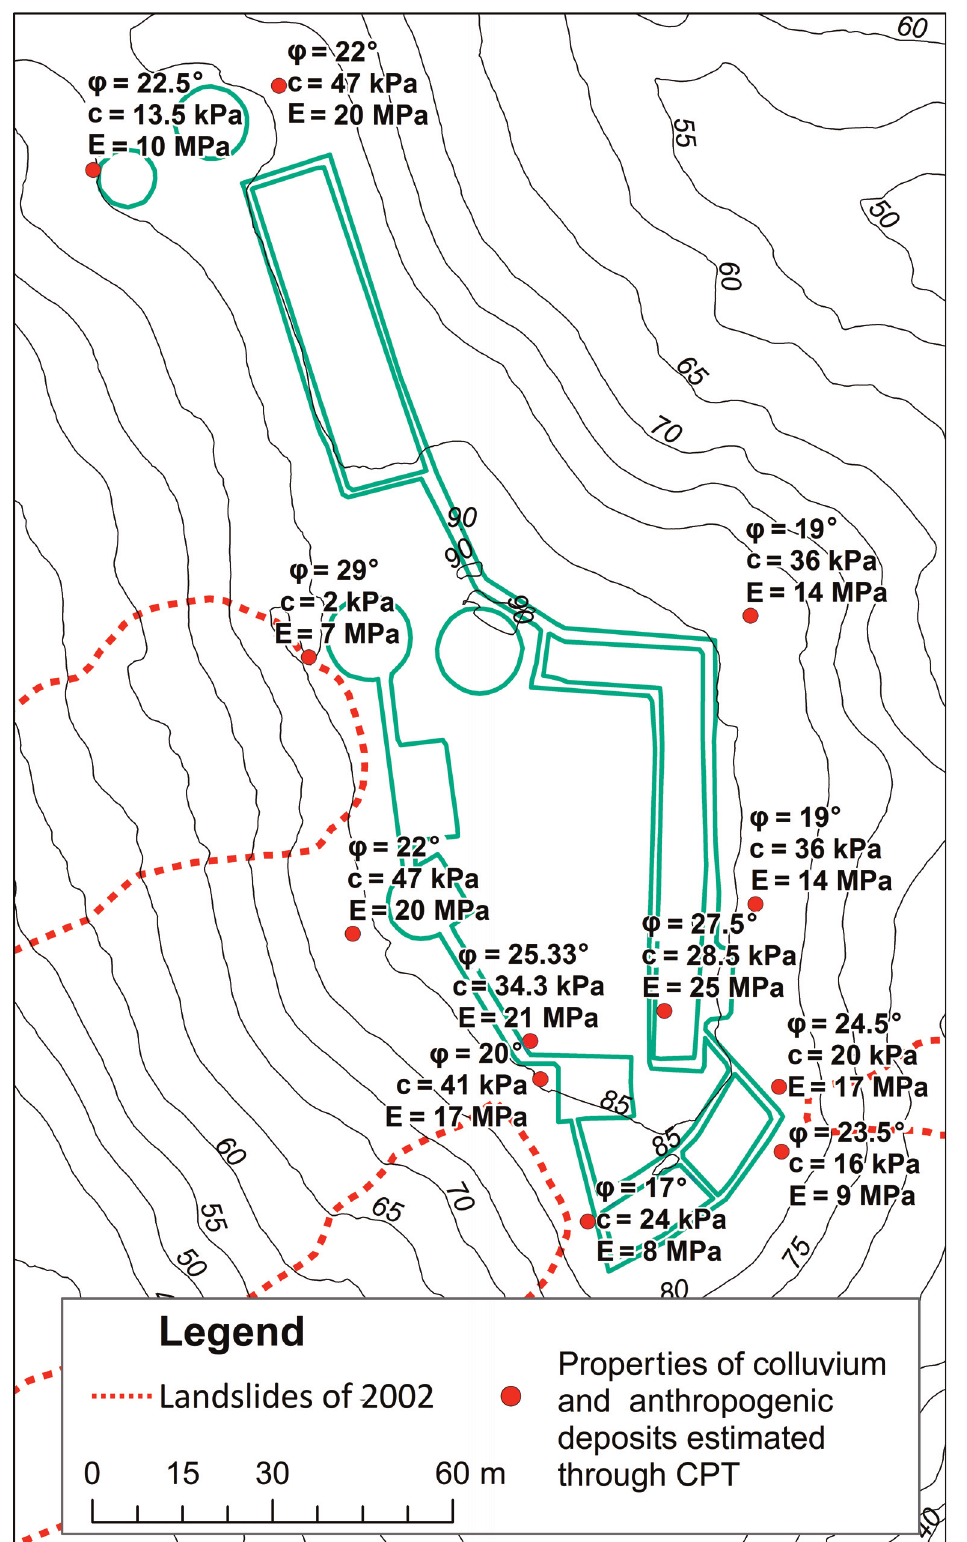
Fig. 3. Geomechanical properties of colluvium and anthropogenic sediments determined in 12 points from cone-penetration tests (CPT) (compiled after M ū rnieks et al. 2002; LGIA